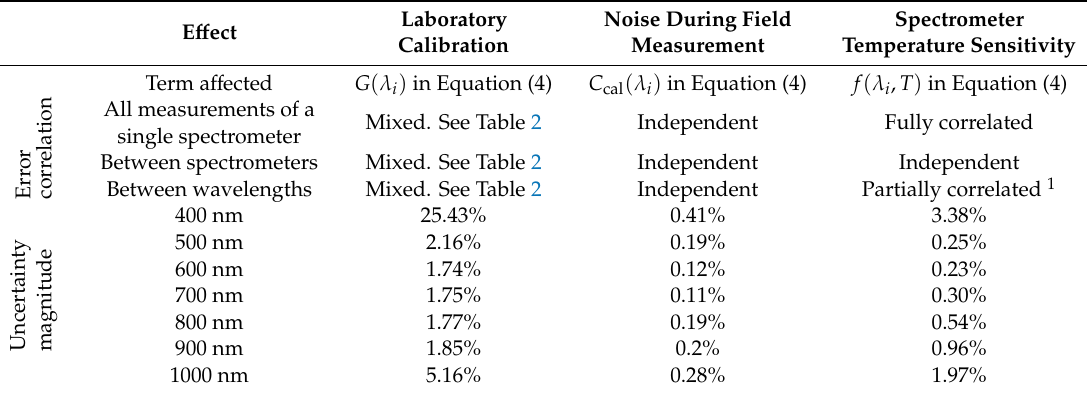
Table 3. The uncertainty associated with field radiance measured by the